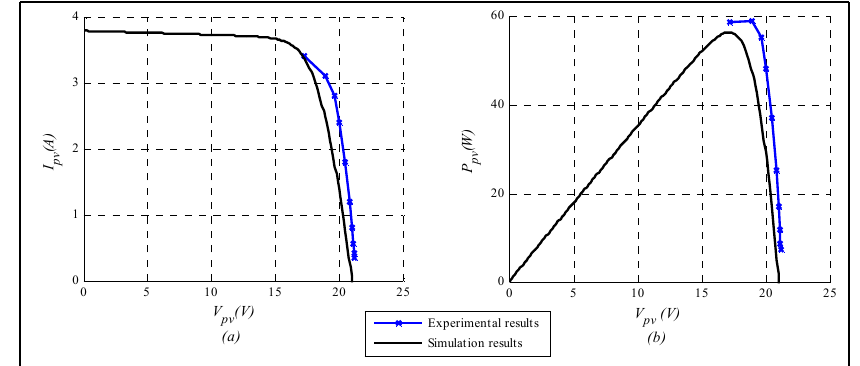
Figure 12. PV emulated characteristics using the resistor load under STC: ( a ) I = f(V) curve. ( b ) P = f(V) curve.